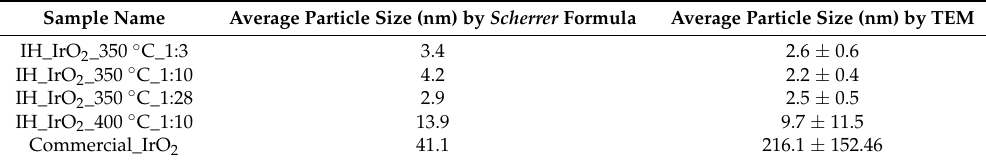
Table 1. Average particle/crystallite sizes for the in-house and commercial IrO 2 samples.